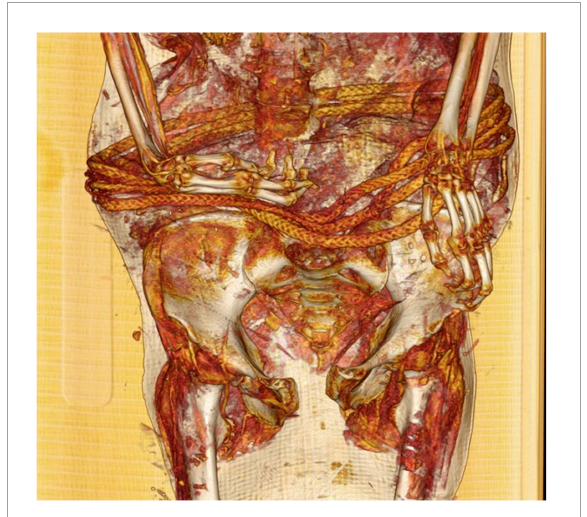
FIGURE13 CT-scan (3D-reconstruction) of the female Delémont mummy showing the belt around the